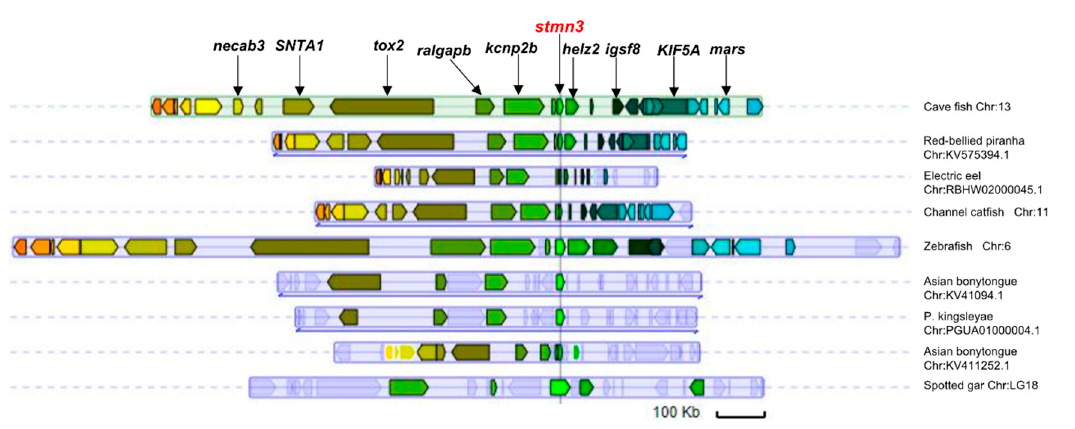
Figure 5. Synteny analyses of the chromosome loci harboring stmn3 genes in several fish. Some genes near Ame_stmn3 loci present conserved synteny in most of the identified species.